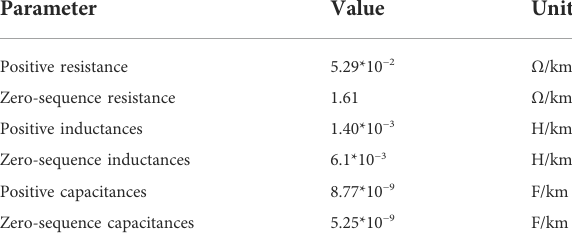
TABLE 2 Parameters of transmission